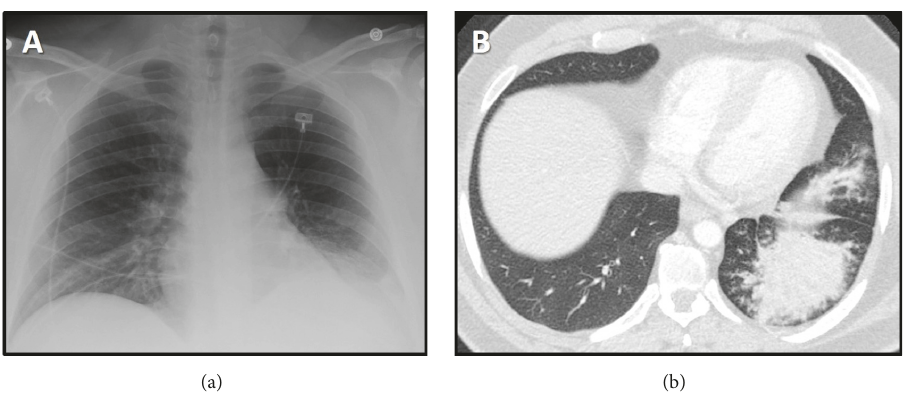
Figure 1: Chest radiograph (a) and computerized tomography (b) demonstrate left basilar lung opacification.